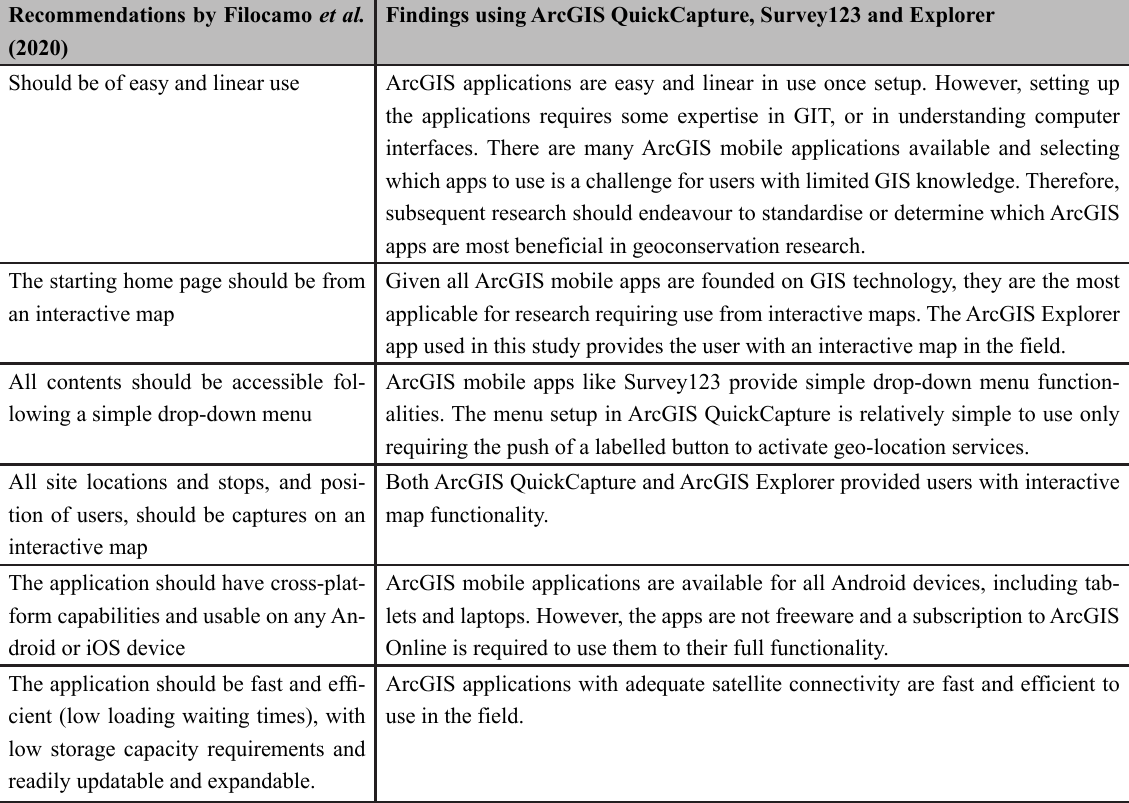
Table 6. Filocamo et al. (2020) made a series of recommendations of what mobile GIS applications should include when used in the field of geoconservation. To demonstrate the viability of our ‘geoconservation toolkit’ concept we compared our findings from implementing the apps. Recommendations by Filocamo et